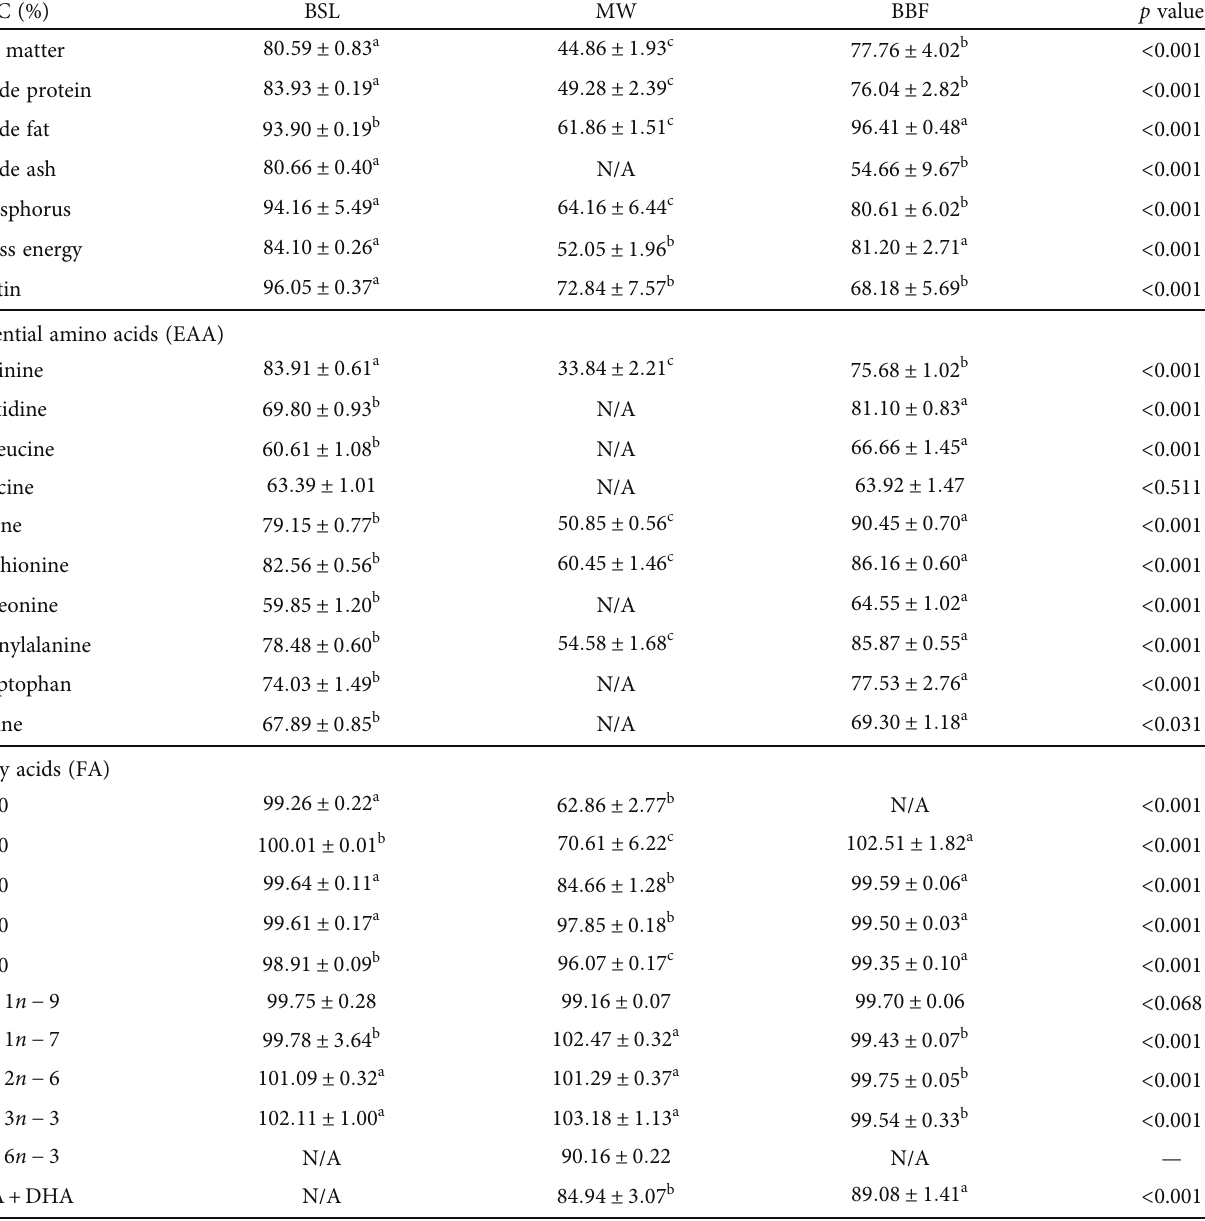
Table 4: Apparent digestibility coe ffi cients of nutrients, gross energy, and chitin of the tested insect meals.